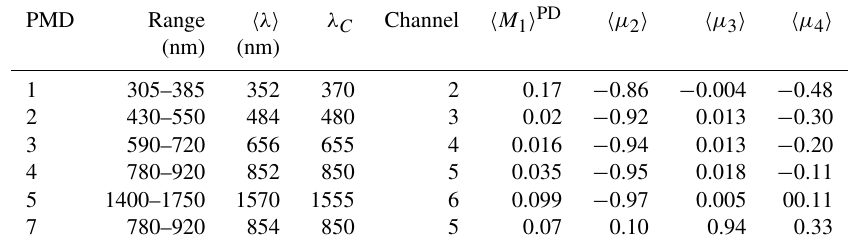
Figure 2. Sketch of the measurement principle of SCIAMACHY. The left part indicates the scanner module with different mirror config- urations, with their optical properties described by the scan mirror model. The scan mirrors can contain a contaminant layer. On the right, the optical bench module is depicted, which includes the telescope, the predisperser prism, and the science channel and PMD detectors. The crossed circle indicates the polarization direction of the PMD beam after internal reflection inside the prism (into the paper). The optical train between the predisperser prism and the PMD and science channel detectors has been omitted; for details, we refer to Gottwald and Bovensmann (2011). Table 1. SCIAMACHY PMDs, their spectral range, average wavelength, reference wavelength, corresponding SCIAMACHY science chan- nel and spectrally averaged OBM Mueller matrix elements for the